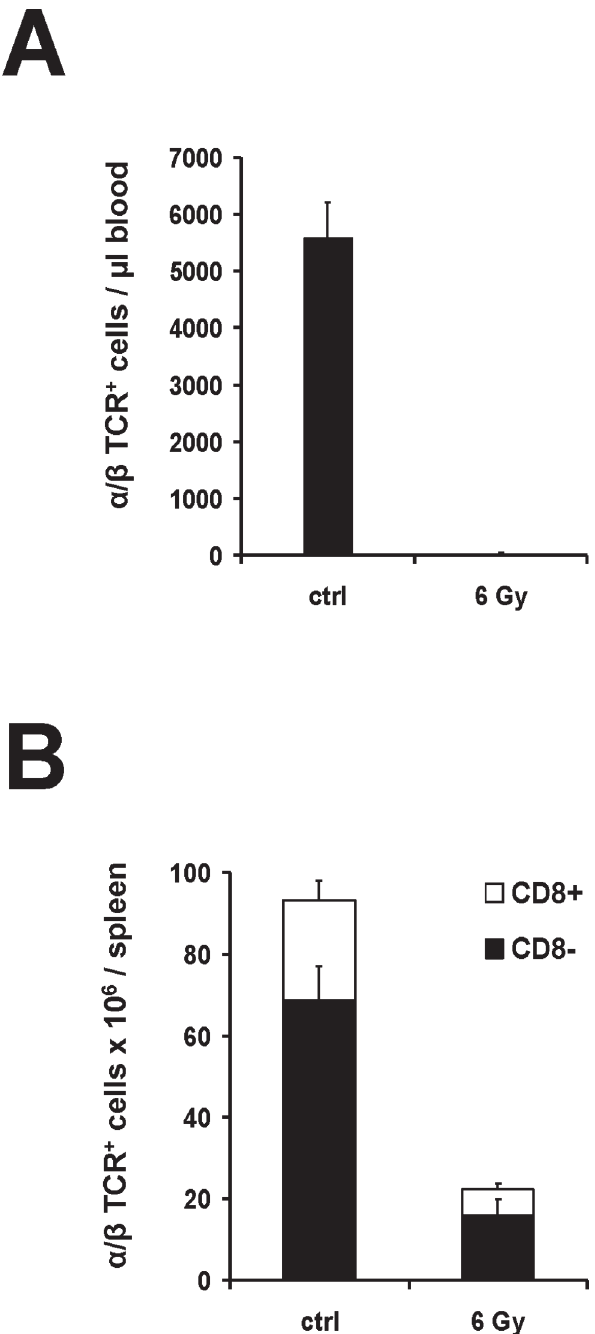
Fig 2. Effects of 6 Gy of TBI on T cell pool. Three male LEW.1AR2 rats were irradiated with 6 Gy of TBI. Analysis was performed on day 3 after TBI. Control animals of identical strain, gender and age did not receive any treatment (ctrl). After counting vital mononuclear cells per μ l blood as well as per spleen, analyses were performed by flow cytometry. T cells with α / β TCR expression (R73 + ) were divided into CD8 + and CD8 - . Propidium-iodid counter-staining was used to exclude avital cells. ( A ) Mean values of absolute numbers of α / β TCR+ cells in peripheral blood. ( B ) Absolute numbers of vital α / β TCR+ cells in spleen subdivided according to CD8 expression as mean